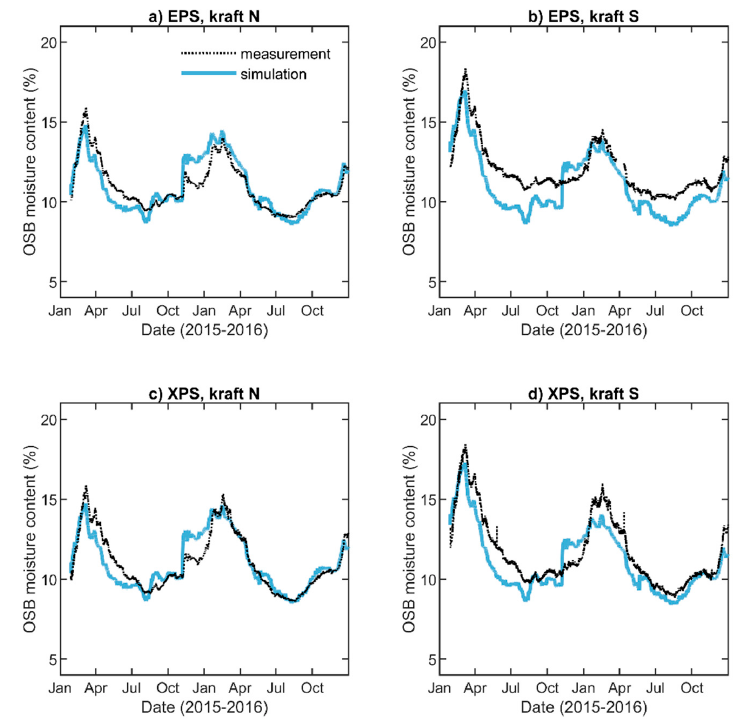
Figure 16. Measured and simulated moisture content of OSB for walls with EPS and XPS insulation.